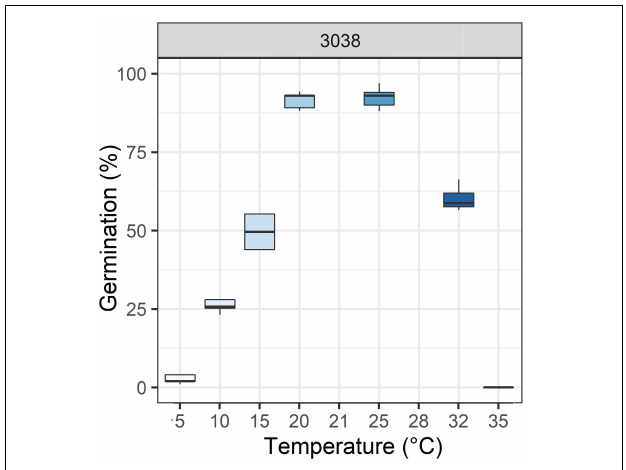
FIGURE 1 | Boxplots of germination percentage in response to different temperatures of the 3038 wild population of perennial ryegrass (Ahmed et al., 2014; Ghaleb, 2019).